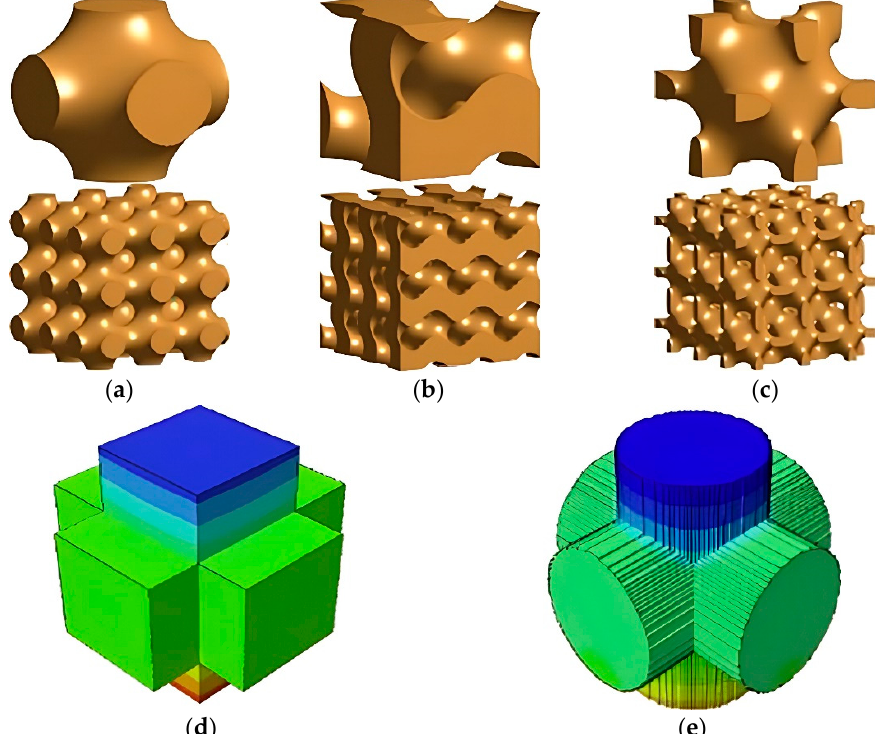
Figure 12. ( a – c ) TPMS structures (bottom) are composed of 3 × 3 × 3 unit cells such as Schwarz Primitive, Gyroid, and Neovius structures, respectively; ( d ) Electric potential distribution on the surface of the intersecting cuboids; ( e ) Electric potential distribution on the surface of the intersecting cylinders (Reprinted from Ref. [82], copyright (2020), with the kind permission of Elsevier Ltd. (Amsterdam, The Netherlands, www.elsevier.com). Table 3. Output voltage of piezocomposites with 50% PZT ceramic under the compressive strain (Reprinted from Ref. [82], copyright (2020), with the kind permission of Elsevier Ltd.).